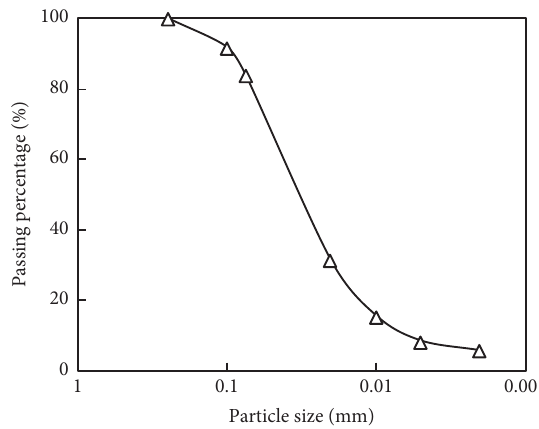
Figure 1: Soil particle sieving